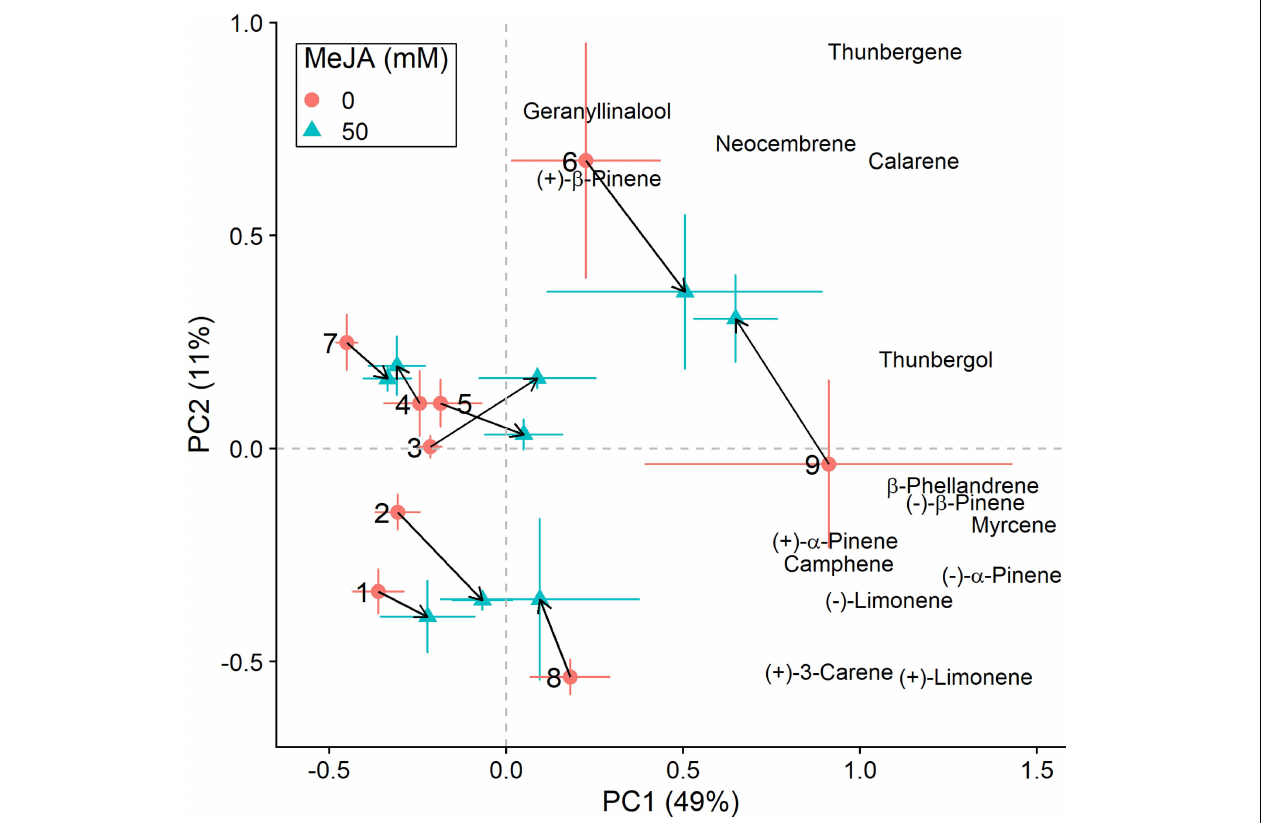
FIGURE 4 | Principal component analysis (PCA) biplots (for E. polonica -inoculated plants) of total absolute terpene amounts. Variation along the two main axes of variation (PC 1, PC 2; % variation explained by each axis) is shown for methyl jasmonate-treated (50 mM MeJA, blue filled triangles) and non-treated (0 mM MeJA, orange filled circles) clones of Norway spruce ( P. abies ). Mean PCA score values ± standard error for each clone (1–9) are shown, as well as the direction and distance of change (black arrows) in terpene chemistry between the two MeJA treatments. The position of terpenes indicates PCA loadings (vectors), which illustrate each compound’s correlation with the two axes of variation (see Table 3 for loading